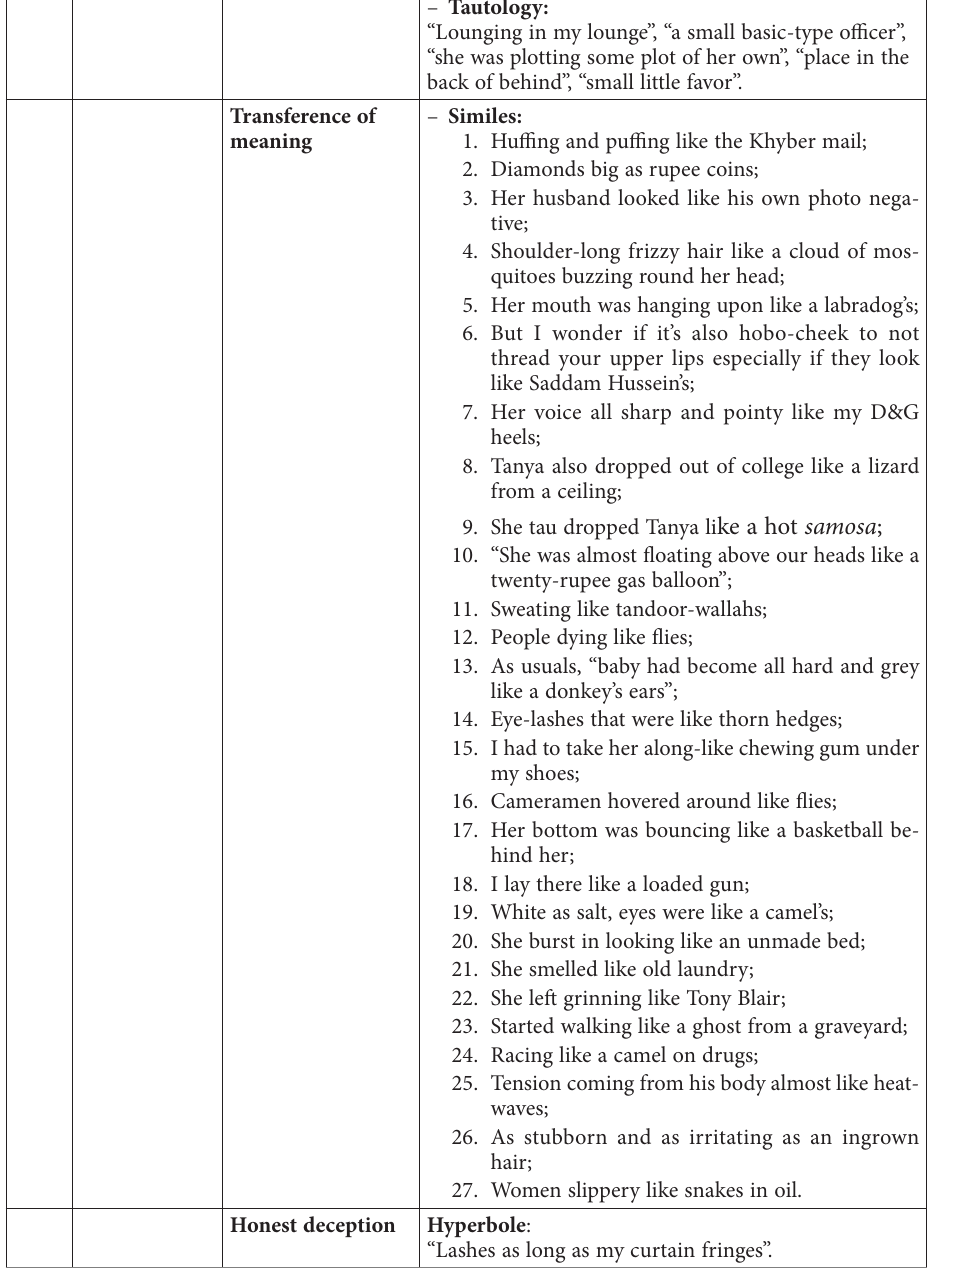
Table 4. Types and examples of semantic deviation in Moni Mohsin’s Duty Free (a novel) (source: cre- ated by author) Sr.